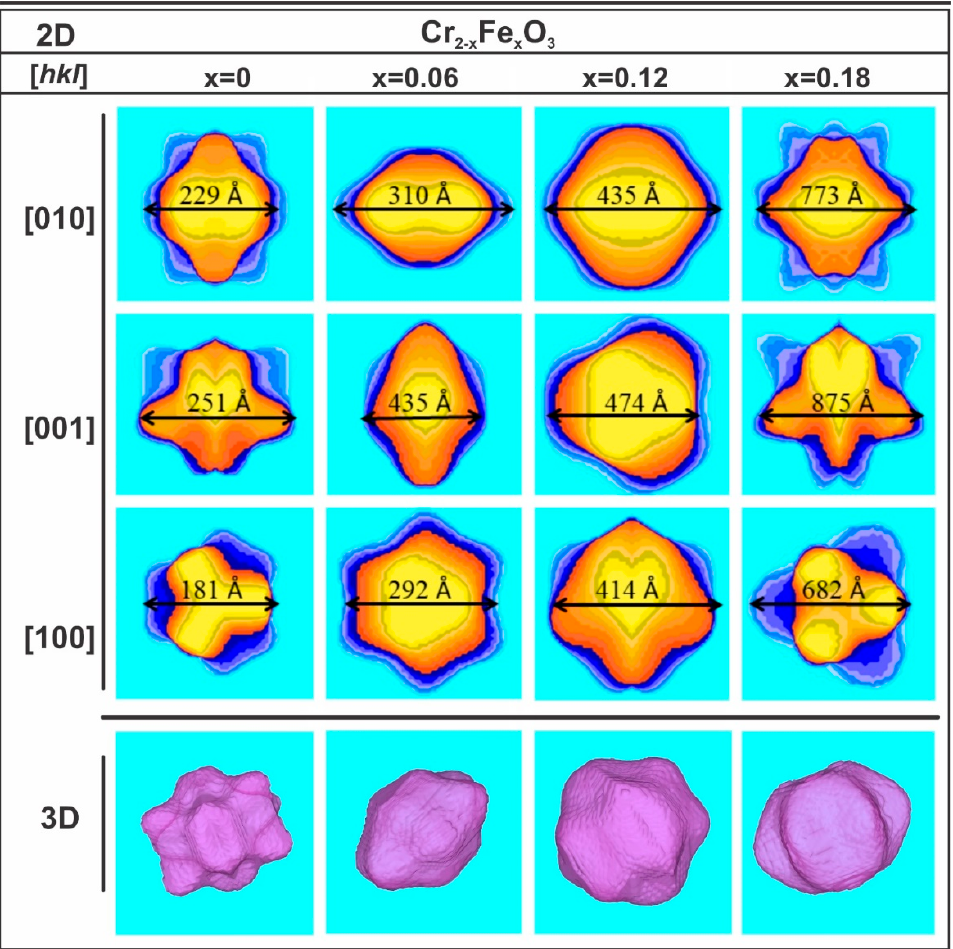
Figure 3. The 2D and 3D apparent crystallite size projections for Cr 2 − x Fe x O 3 (0.0 ≤ x ≤ 0.18) nanoparticles along the [010], [001], and [100] crystallographic